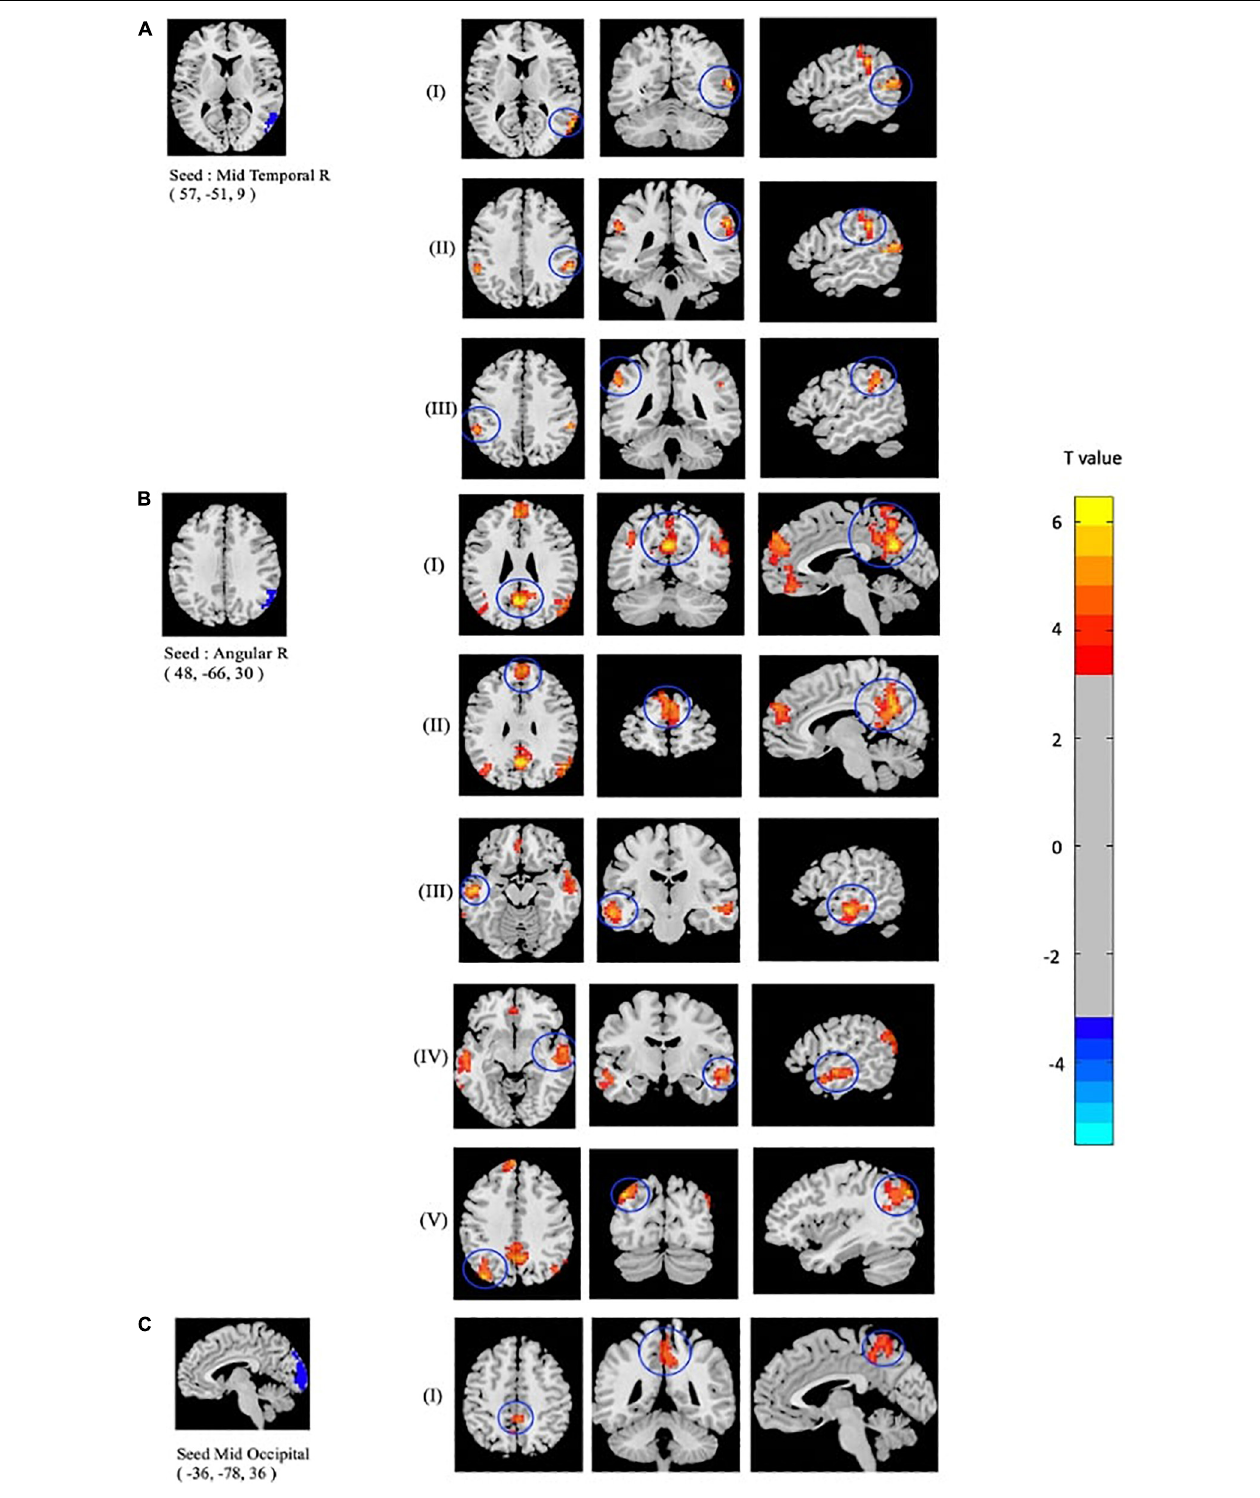
FIGURE 3 | Altered seed-based functional connectivity (FC) in mTBI patients compared with controls including increased FC between the seed located at (A) Temporal_Mid_R, and clusters located at (I): Temporal_Sup_R, (II): SupraMarginal_R, and (III): Parietal_Inf_L, as well as the seed located at (B) Angular_R and clusters located at (I): Precuneus_L, (II): Frontal_Sup_Medial_L, (III): Temporal_Mid_L, (IV): Temporal_Sup_L, (V): and Occipital_Mid_L. In addition, altered FC between the seed located at (C) Occipital_Mid_R and (I): Precuneus_R is shown ( p -value < 0.001, FDR-corrected). The range of t -values is represented by the color bar. Hot colors corresponding with increased seed-based FC values in the mTBI group. *Note that the right side of the image as displayed is the right side of the person.